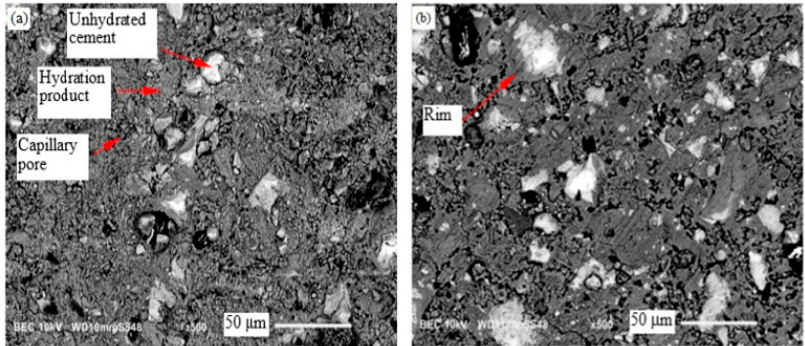
Figure 3. SEM images of cement (ordinary Portland cement (OPC)) paste at the age of three days, ( a ) cured at room temperature, and ( b ) cured at 60 °C. Adapted with permission from [47], MDPI, 2016.